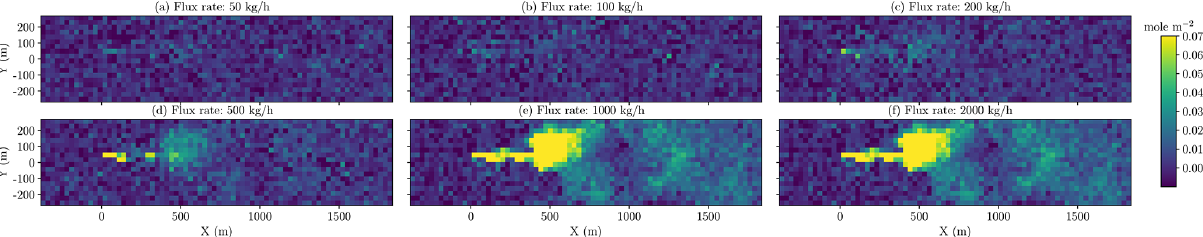
Figure 18. Retrieved CH 4 column over a well pad in the Durango, Colorado, area for plumes of various emission rates. The spatial resolution is 30m, the instrument FWHM is 1.5nm, and the polynomial degree in the retrieval is 25. The realistic surface distribution is based on LANDSAT data. Column enhancement in the vicinity of the CH 4 plume is increasingly visible as the source emission rate becomes